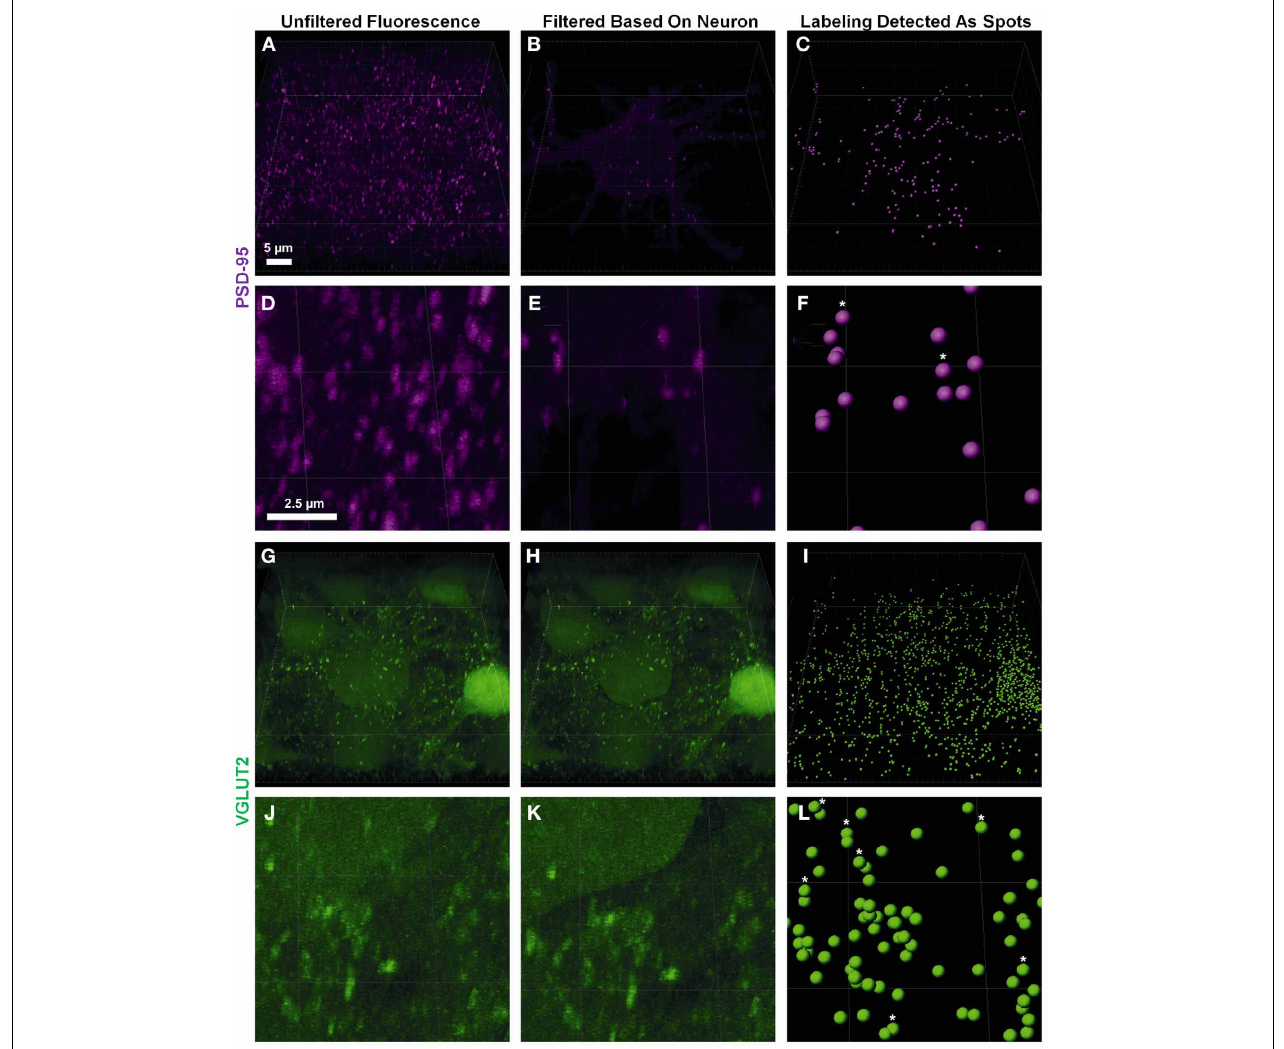
FIGURE 2 | Defining pre- and post-synaptic spots. (A,D) show low and high power magnification of post-synaptic PSD-95 (purple) fluorescence in the entire confocal z -stack from Figure 1 . (B,E) show the post-synaptic PSD-95 (purple) fluorescence filtered to inside the neuronal surface using the “ mask all ” tool in Imaris. (G,J) show low and high power magnification of pre-synaptic VGLUT2 (green) fluorescence in the entire